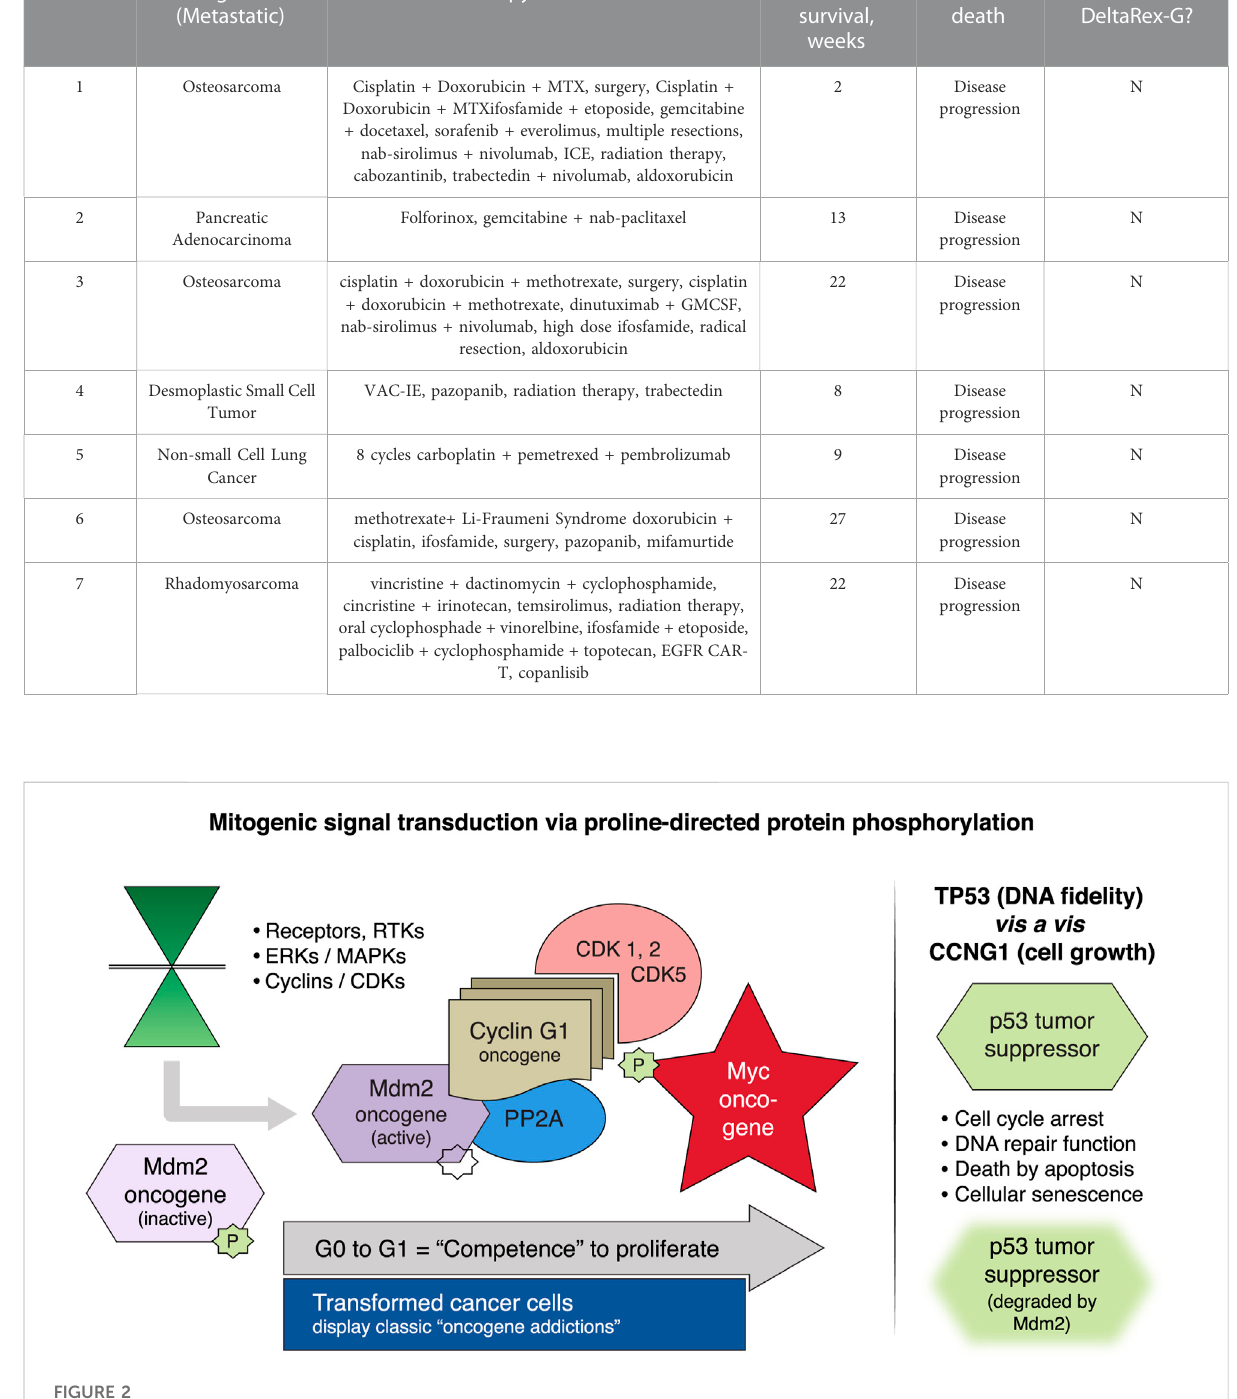
FIGURE 2 Mitogenic signaling pathways focused on the human cyclin G1 ( CCNG1 protooncogene). Left panel, MAPKs/ERKs and CDK complexes control the progressive phases of the cell division cycle. CCNG1 physically binds to the PP2A to activate a key regulatory oncoprotein, Mdm2. The Mdm2 oncoprotein forms a physical complex with the p53 tumor suppressor, thus inactivating its tumor suppressor function, while also acting as a speci fi c E3 ubiquitin ligase responsible for the ubiquitination and degradation of the p53 tumor suppressor protein. This dephosphorylation event isCCNG1-dependent. CCNG1 alsoactivates CDK5and CDK1/2 totarget/activate thec-Myconcoprotein.Rightpanel, TP53tumorsuppressor functions are presented as opposite to the CCNG1 growth-promoting function. CCNG1 , cyclin G1; RTK, receptor tyrosine kinase; MAPKs, mitogen- activated protein kinases; ERKs, extracellular-signal-regulated kinases; CDK, cyclin-dependent kinase; PP2A, serine/threonine protein phosphatase subunit designated 2A; Mdm2, mouse double minute 2 homolog; TP53, tumor protein p53 (Morse et al.,